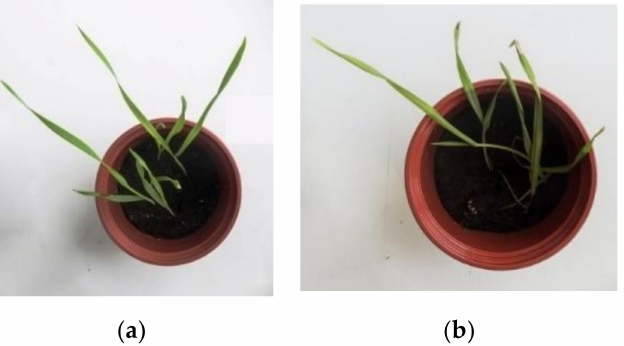
Figure 8. Comparison of the physical appearance of the rye shoots ( Sec á le ): ( a ) control, ( b ) after treatment with the pesticide